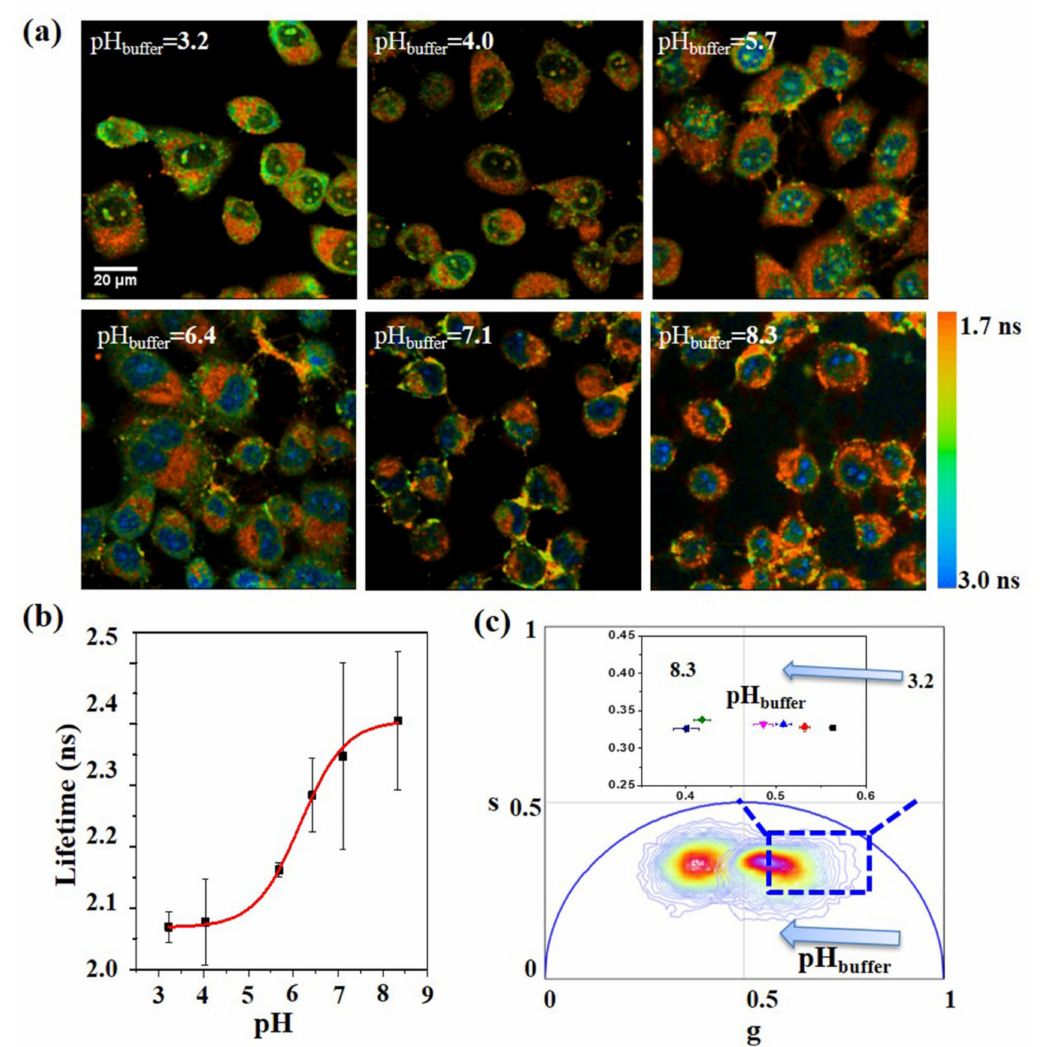
Figure 2. pH response of CDs in HeLa living cells. ( a ) Fluorescence lifetime images of cells labeled with CDs at di ff erent pH bu ff ers, scale bar: 20 µ m. ( b ) The relationship between the average fluorescence lifetime and the pH values of the FLIM images in ( a ). ( c ) A phasor diagram obtained using the phasor analysis of the FLIM images in ( a ), in which the enlarged part of the phasor diagram gives the maximum density of the corresponding phasor plot for each pH